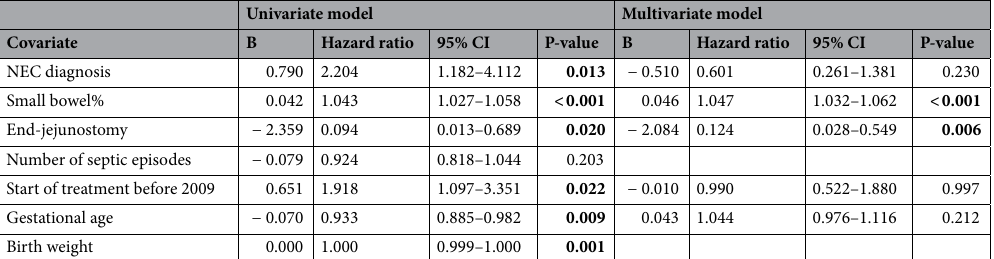
Table 2. Cox regression analysis for weaning of PN at five years. Significant values are in bold. NEC necrotizing enterocolitis, PN parenteral nutrition, small bowel % age-adjusted small bowel